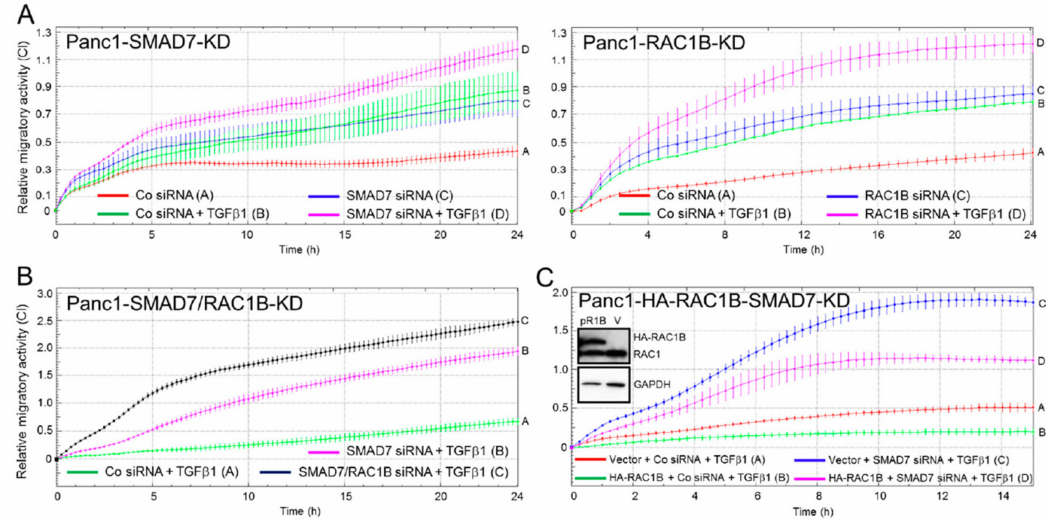
Figure 5. E ff ect of single or combined knockdown of SMAD7 or RAC1B on basal and TGF β 1-induced cell migration in Panc1 cells. ( A ) Panc1 cells were transfected twice on two consecutive days with 50 nM of irrelevant control (Co) siRNA and either SMAD7 siRNA (left-hand graph) or RAC1B siRNA (right-hand graph) as control. Then, 48 h later, the transfected cells were subjected to real-time cell migration assay (chemokinesis setup) in the absence or presence of TGF β 1. In both graphs, data show the mean ± SD of 3–4 wells per condition and are representative of three experiments with very similar results. Left-hand graph: Di ff erences between Panc1 + Co siRNA + TGF β 1 (green curve, tracing B) and Panc1 + SMAD7 siRNA + TGF β 1 (magenta curve, tracing D) are significant the first time at 02:00 and all later time points. Right-hand graph: Di ff erences between Panc1 + Co siRNA + TGF β 1 (green curve, tracing B) and Panc1 + RAC1B siRNA + TGF β 1 (magenta curve, tracing D) are significant at 04:00 and all later time points. ( B ) As in ( A ), except that Panc1 cells were transfected twice with 50 nM of Co siRNAs or 25 nM each of SMAD7 and Co siRNA, or 25 nM each of SMAD7 and RAC1B siRNA. Then, 48 h after the second round of transfection, cells were assayed for migratory activity on an xCELLigence platform in the presence of TGF- β 1. ( C ) Panc1 cells stably expressing HA-RAC1B (pR1B) or empty pCGN vector (V) (verified by immunoblotting in inset) were transfected twice with either 50 nM of Co siRNA or SMAD7 siRNA. Only TGF β -treated cells are shown. Di ff erences between Panc1-vector + SMAD7 siRNA + TGF β 1 (blue curve, tracing C) and Panc1-HA-RAC1B + SMAD7 siRNA + TGF β 1 (magenta curve, tracing D) are significant at 02:00 and all later time points. Successful inhibition of SMAD7 and RAC1B expression was verified by immunoblotting (see Figures 4A and 1A,